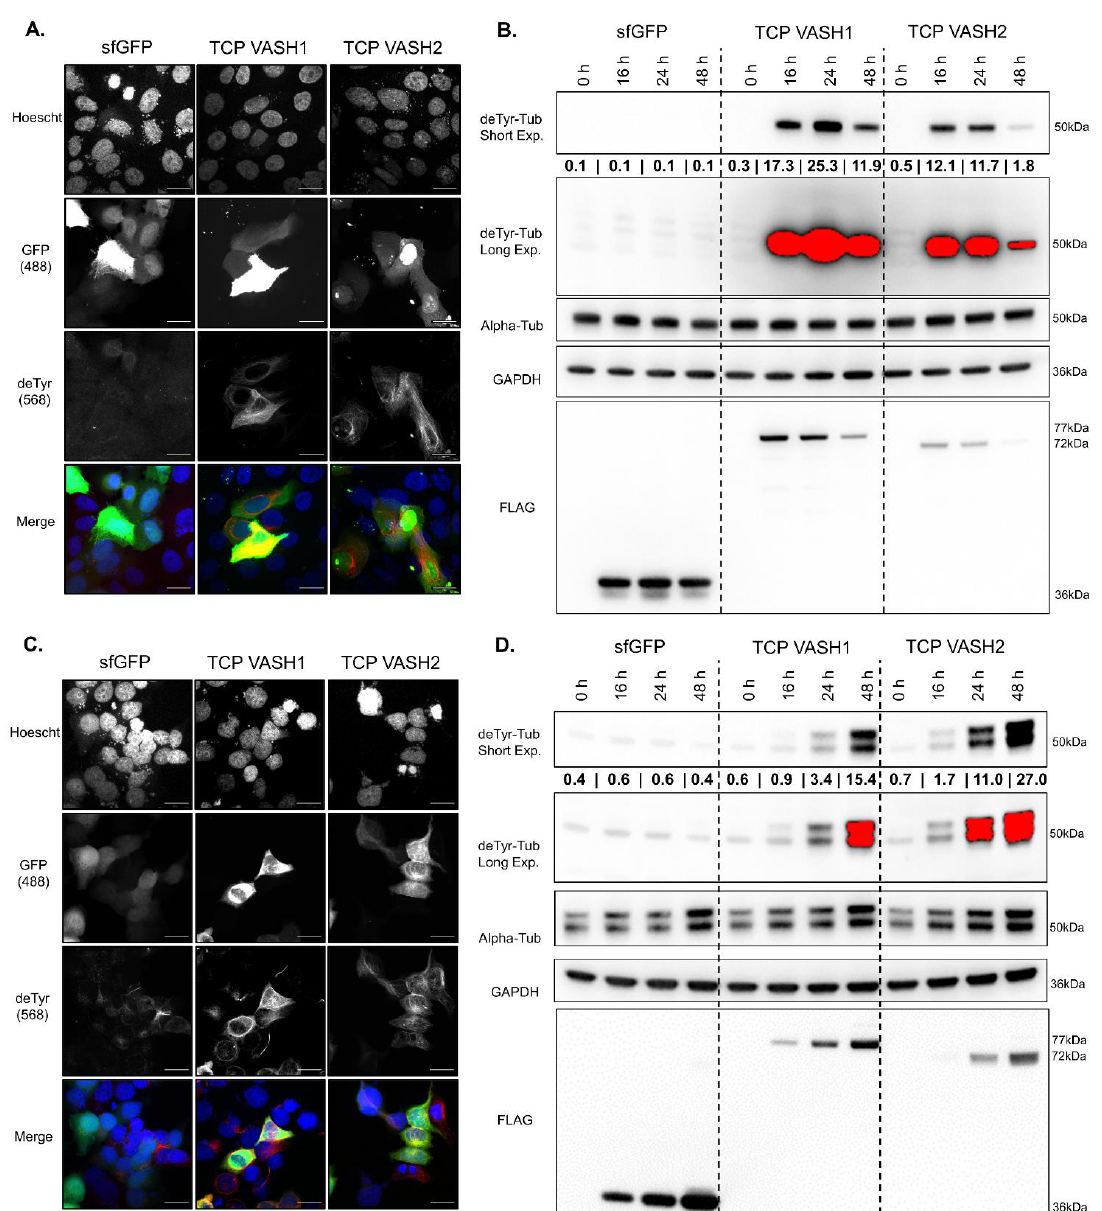
However, vasohibin alone only detyrosinates a subset of microtubules, and SVBP alone has no effect on the abundance of deTyr-Tub (Figure 2B,D).